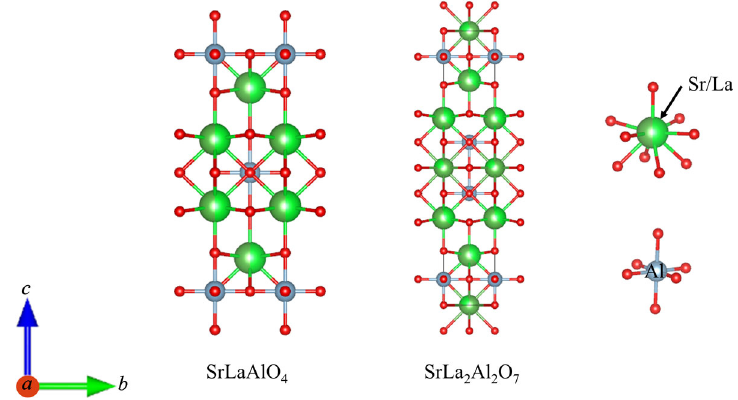
Fig. 26 Crystal structures of SrLaAlO 4 and SrLa 2 Al 2 O 7